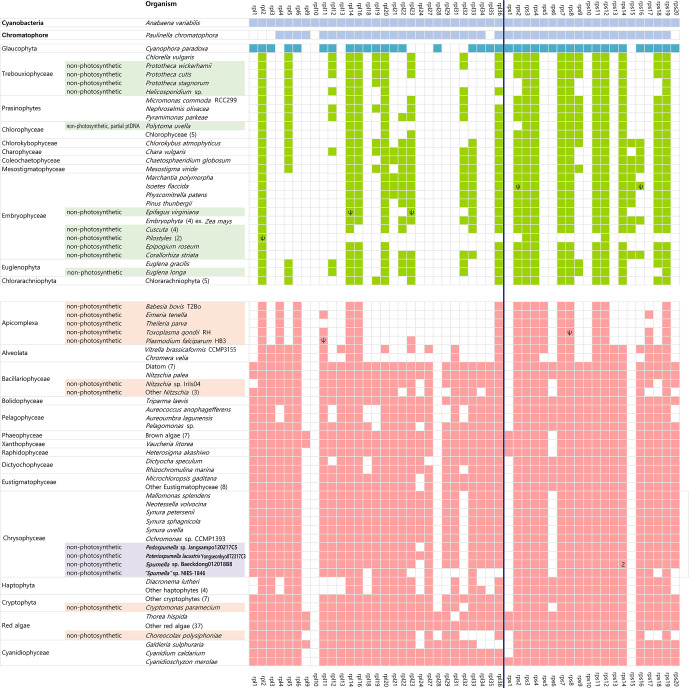
Presence/absence of plastid-encoded ribosomal protein genes in diverse algae and the cyanobacterium Anabaena variabilis. Taxa highlighted bold correspond to those specifically analyzed in this study. Filled boxes indicate the presence of ribosomal protein genes (green=green alga-derived secondary plastid lineage; red=red alga-derived plastid lineage). The missing ribosomal protein genes (i.e., rpl7, rpl8, rpl15, rpl17, rpl25, rpl26, rpl30, and rps21) were not detected in the plastid genomes of any of the lineages examined herein. Accession numbers and fully surveyed datasets are provided in
Supplementary Table S1
, online
Supplementary Material. 2
, multi-copy genes; Ψ, pseudogenes.